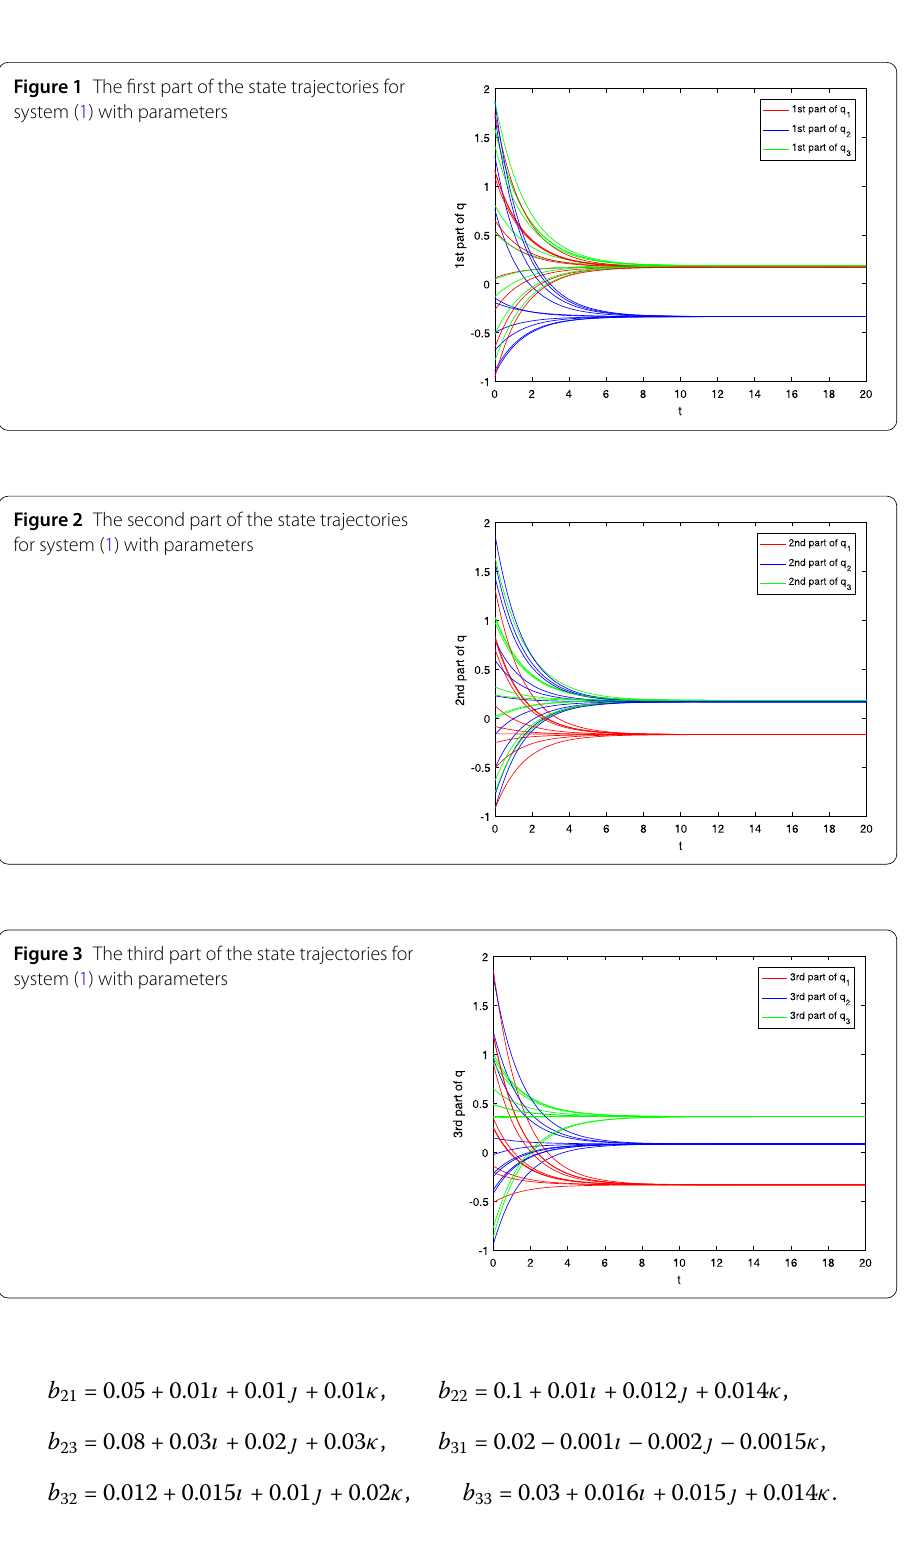
Figure 1 The first part of the state trajectories for system (1) with parameters